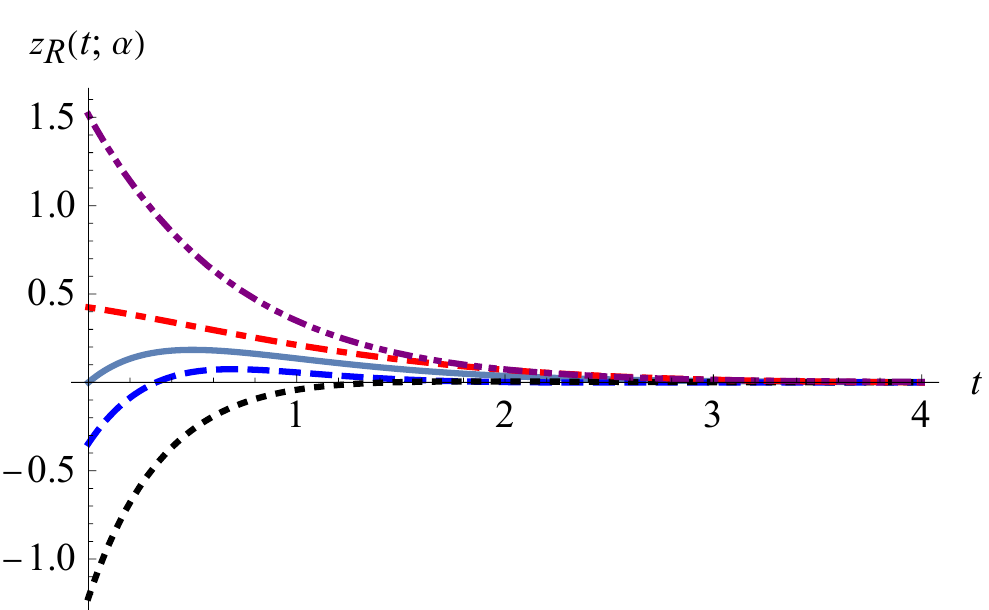
Figure 17. Curves of z ( t ;1 ) (solid line) and residue contribution z R ( t ; α ) for α = 0.9 (dash line), 0.99 (dot line), 1.1 (dot-dash line), 1.01 (dot-dot-dash line), where b = 4 and c = 4 ( b 2 − 4 c = 0).